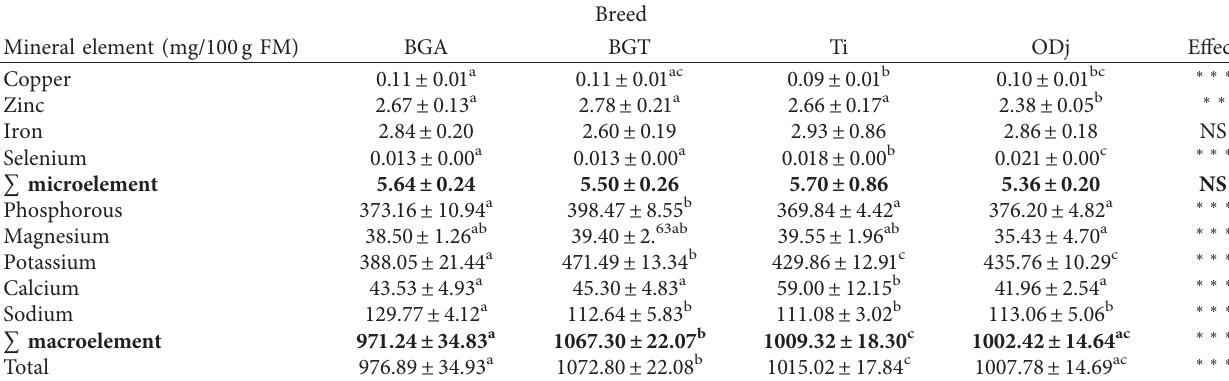
Table 3: Minerals composition of Beni-Guil, Timahdite, and Ouled-Djellal sheep meats.